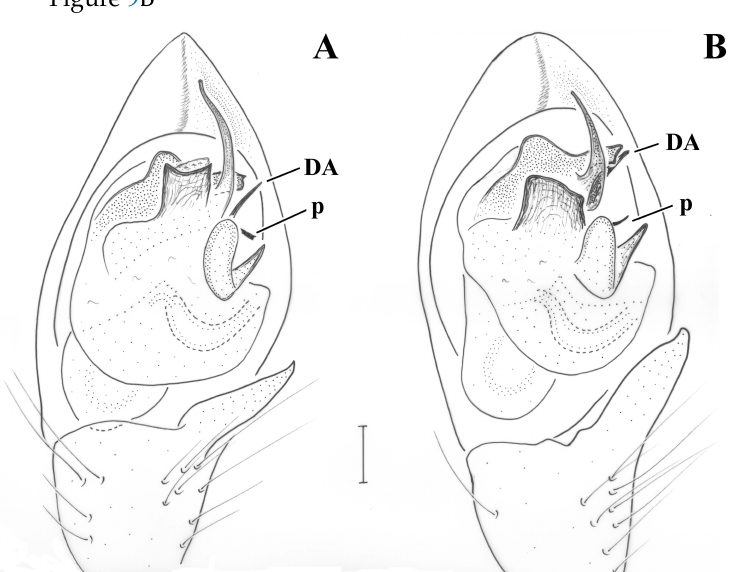
Figure 9. Drassyllus dadianus n.sp. (holotype), and D. dadia (holotype), male pedipalps, ventral view. ( A ) D. dadianus n.sp., ( B ) D. dadia . p: transverse projection, DA: dorsal